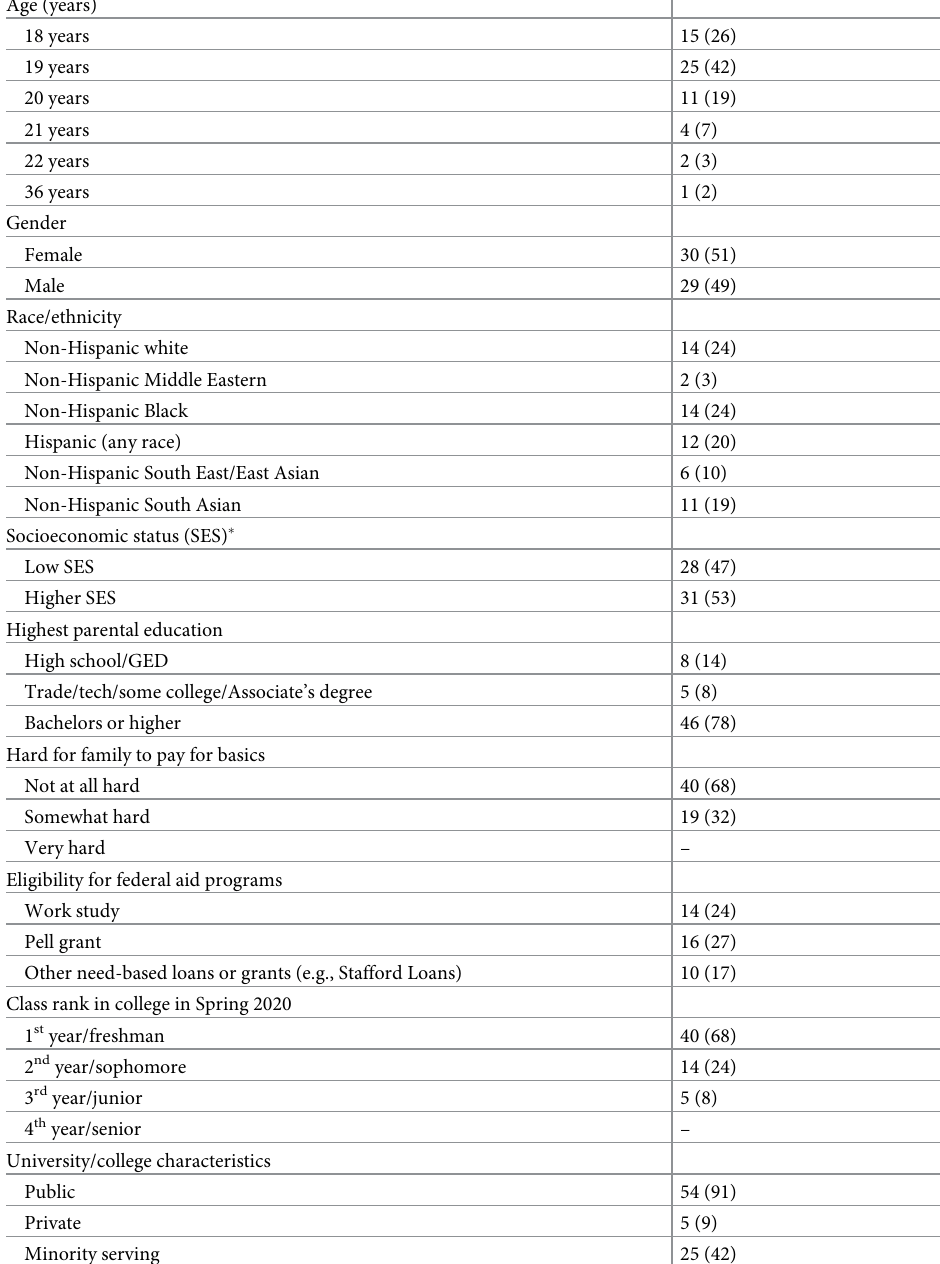
Table 1. Characteristics of undergraduate students majoring in STEM fields at US colleges/universities who par- ticipated in focus groups in summer 2020, n